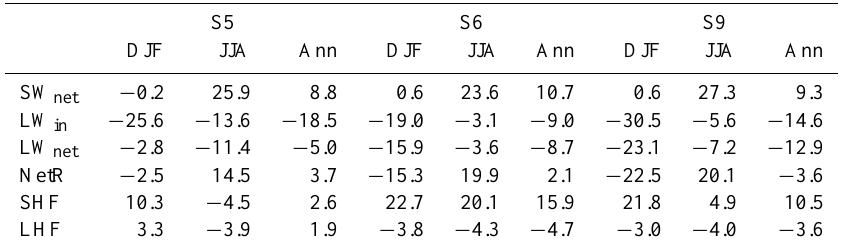
Table 2. Seasonal and annual bias between the modelled and observed surface energy fluxes [Wm − 2 ] for the stations S5, S6 and S9 over the period August 2003–August